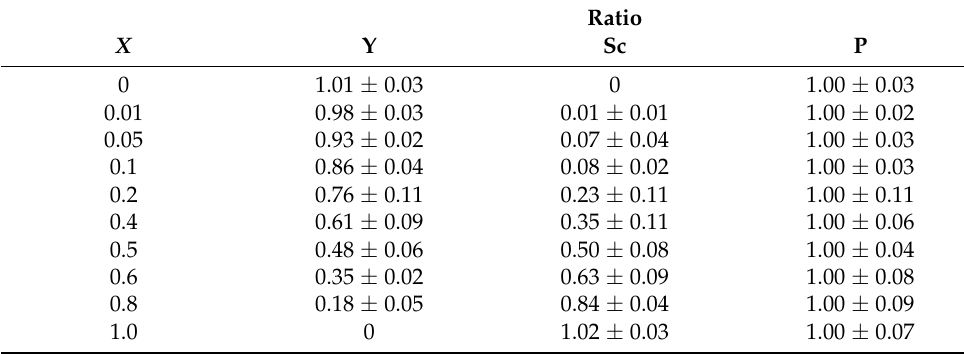
Table 2. EDX data for Y 1 − x Sc x PO 4